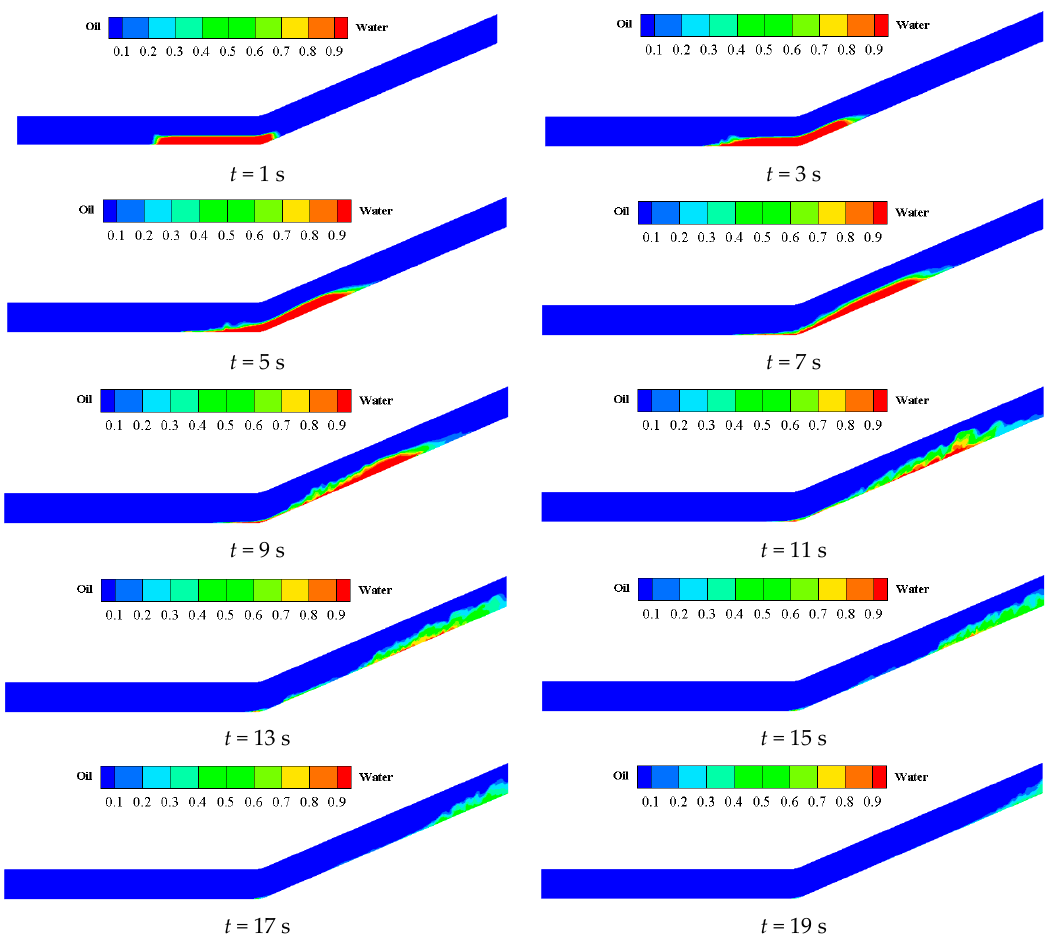
Figure 8. Phase distribution of water-carrying process ( α = 10°).